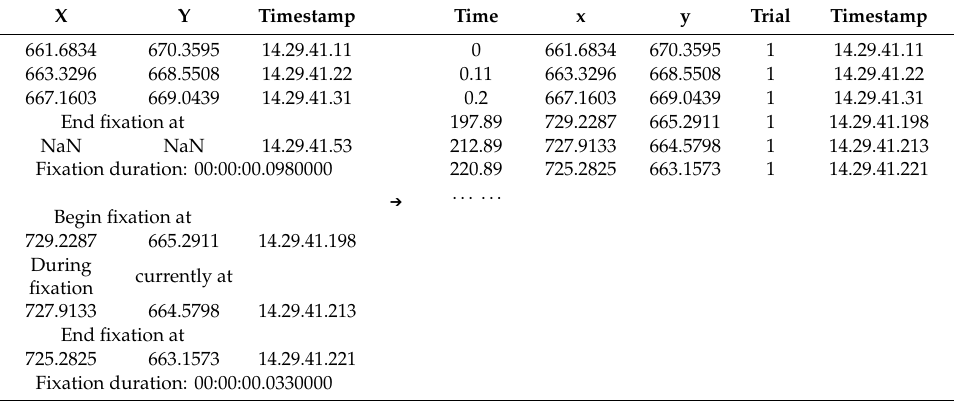
Table 1. Example of cleaning XY coordinate data.